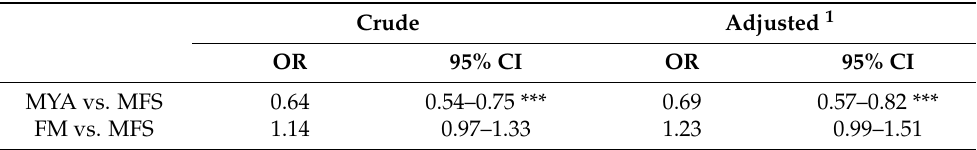
Table 4. Multinomial logistic regression analyses assessing the association between the number of comorbid conditions and diagnosis (dependent variable). In this analysis, individuals with MFP were set as a reference against which the other groups were